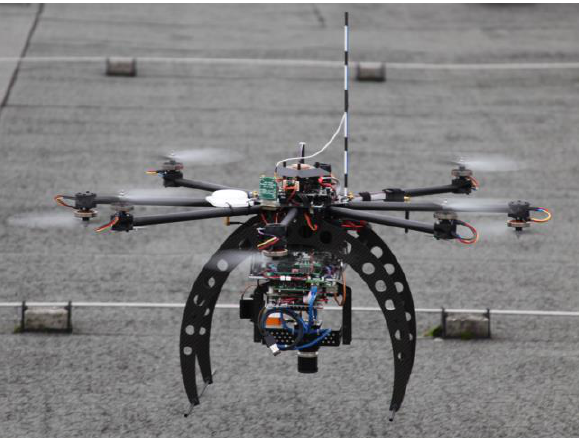
Figure 8: Current setup of the mounted aerial camera